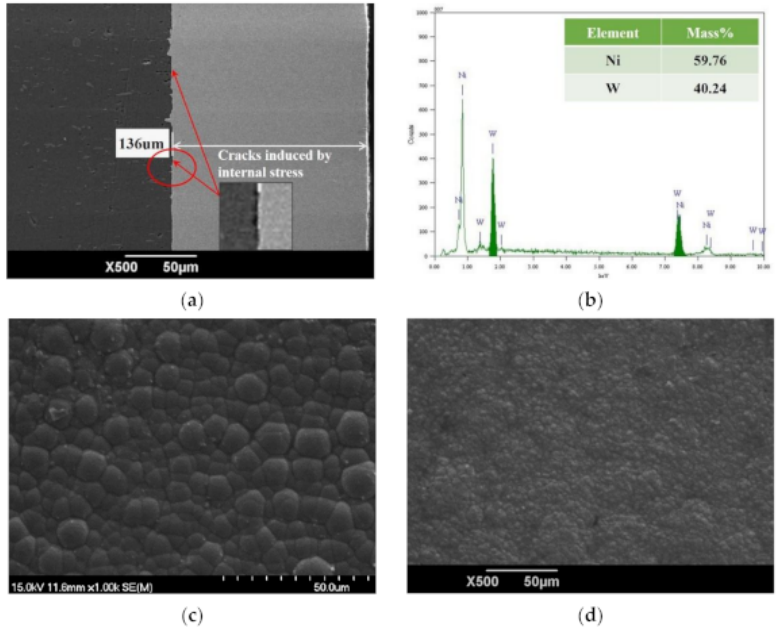
Figure 6. SEM images and EDS of Ni–W alloy coatings: ( a ) Section morphology; ( b ) EDS spectra; ( c ) Surface morphology before oxidation; ( d ) Surface morphology after oxidation at 400 ◦ C/8 h in air.